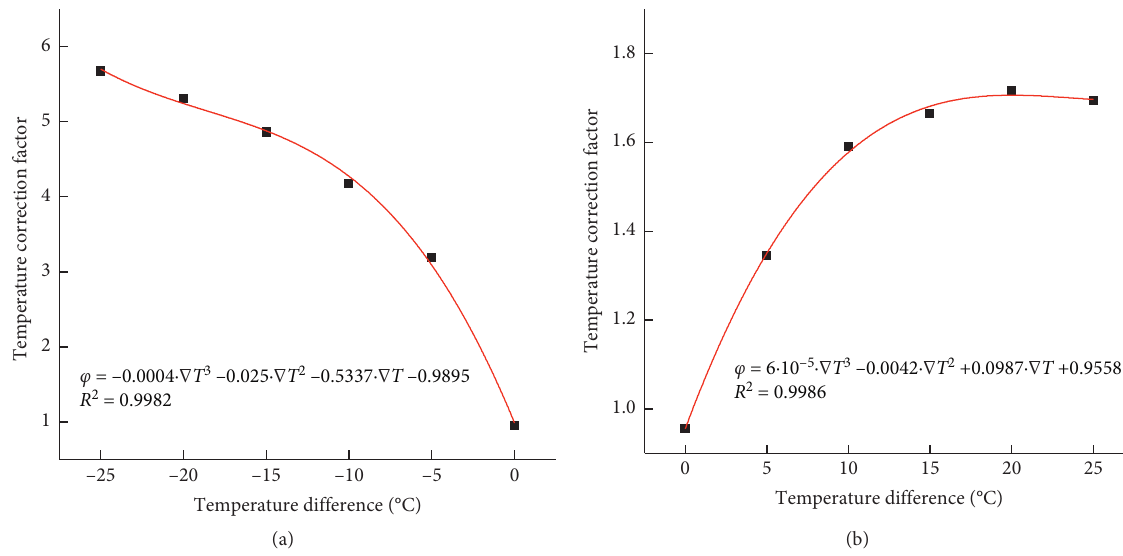
Figure 7: Correlation between positive and negative temperature differentials and mean correction coefficient. (a) Negative temperature range. (b) Positive temperature range.